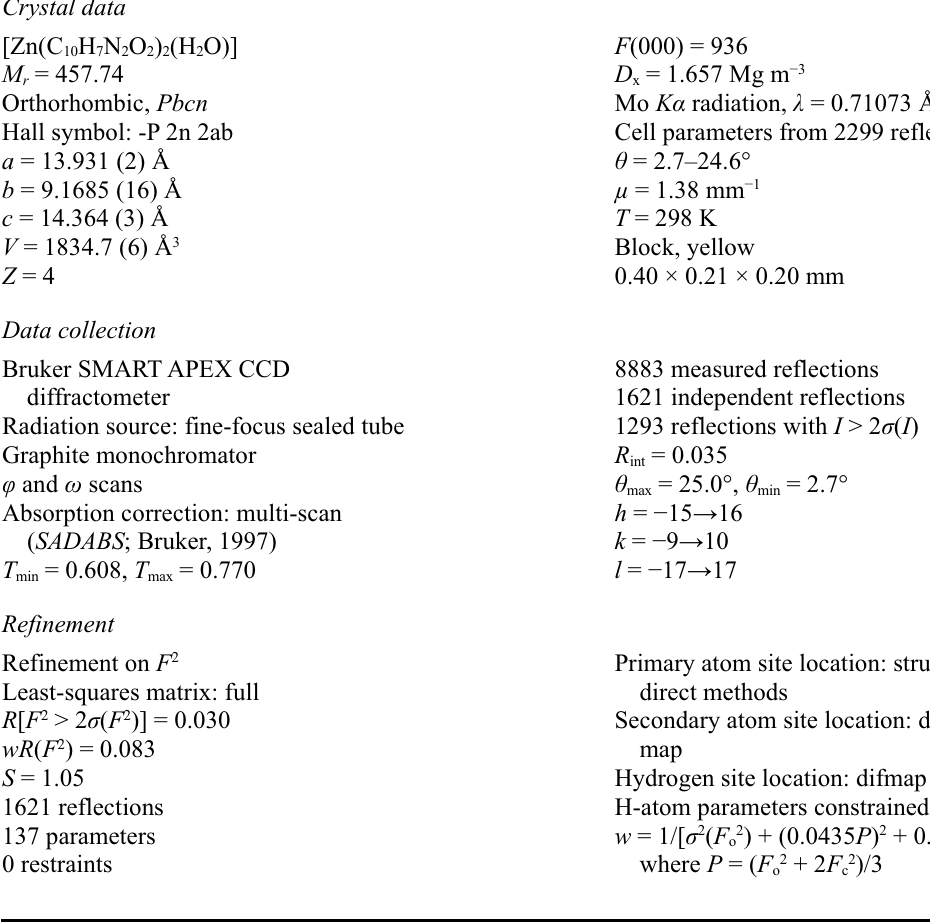
Figure 2 Intermolecular hydrogen bonds (dashed line) in the crystal of (I). Aquabis(3 ′ -hydroxy-2,2 ′ -bipyridine-3-olato- κ 2 N,N ′ )zinc(II) Crystal